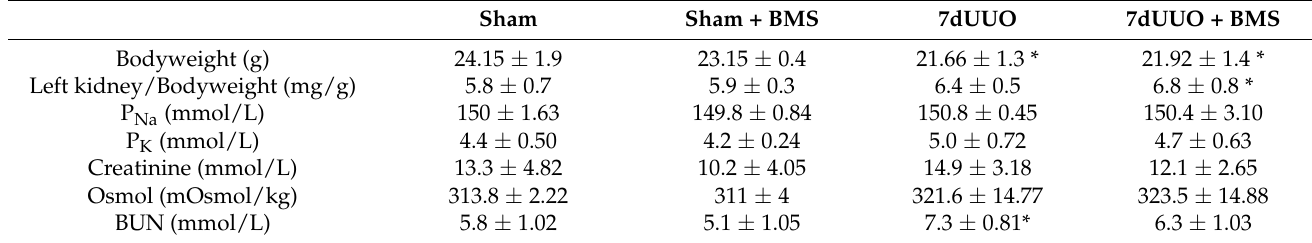
Table 4. Functional data after UUO and BMS-986205